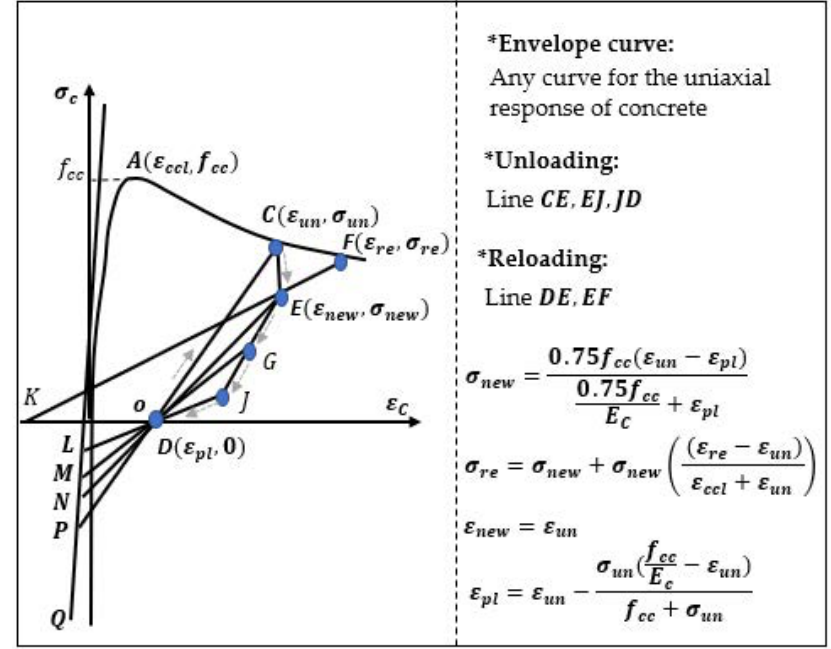
Figure 4. Concrete model according Yankelevsky and Reinhard [30].